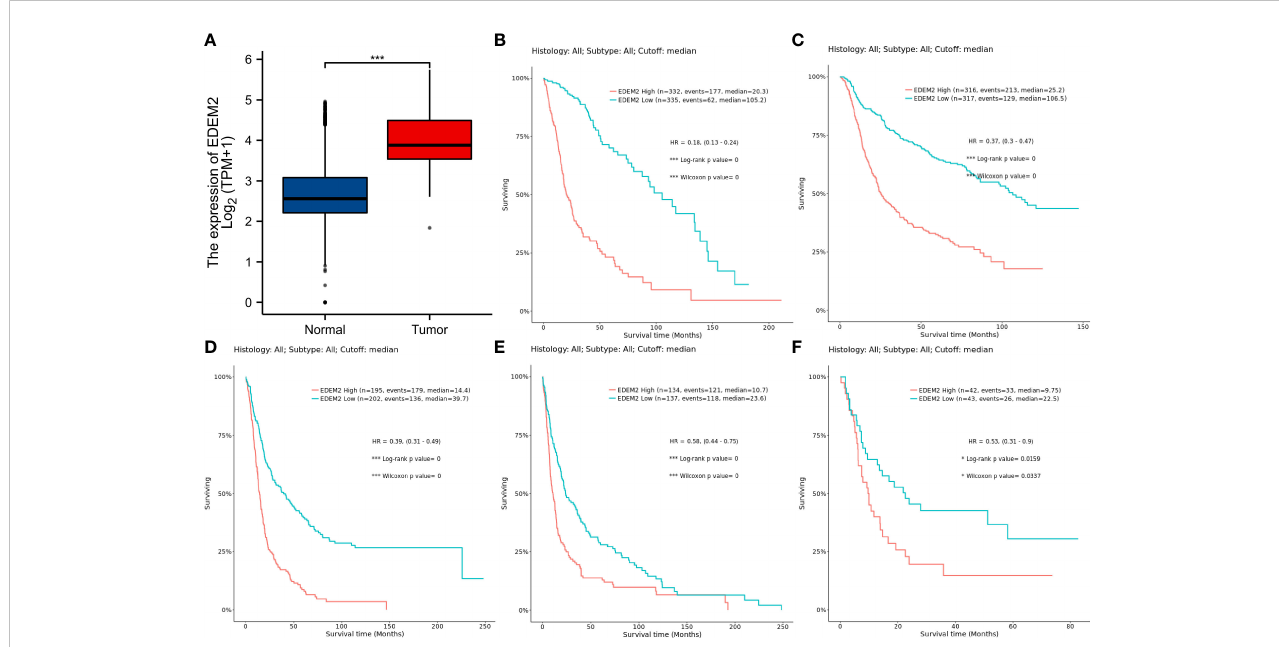
FIGURE 1 Differential expression analysis of EDEM2 versus normal tissues and Kaplan-Meier curves for multiple datasets pertaining to OS. (A) EDEM2 expression in gliomas as determined by TCGA and the GTEx databases. (B) TCGA-GBMLGG dataset. (C) CGGA (Primary) dataset. (D) Rembrandt dataset. (E) Gravendeel dataset. (F) Freije dataset. * p< 0.05;